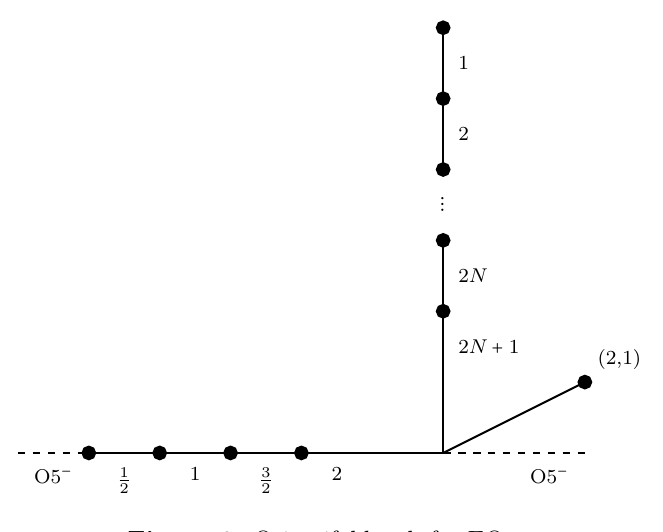
Figure 6. Orientifold web for EQ 3 ′ , 4